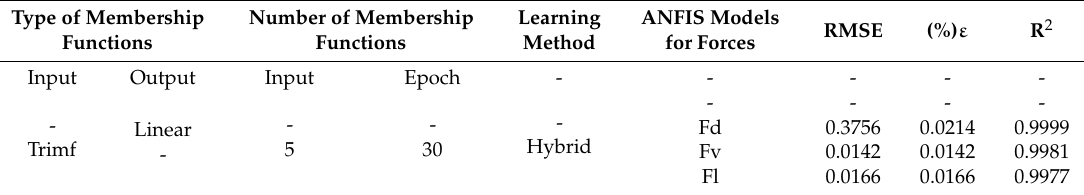
Table 4. Characteristics of ANFIS models and evaluation based on statistical